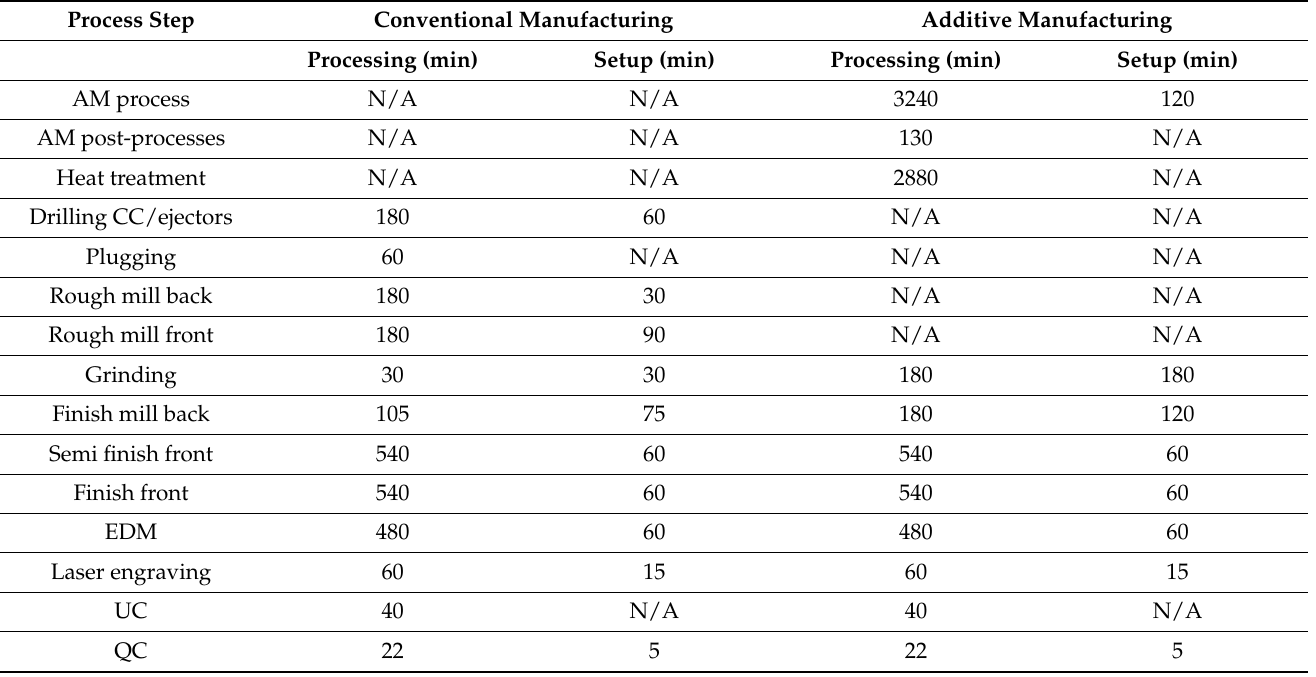
Table 1. Time data for CM and AM manufacturing flow (N/A: not